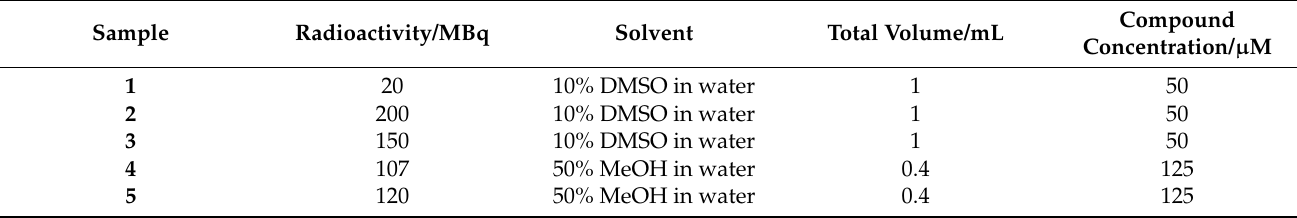
Table 2. Trials from cagedAZD5438 activation experiments using 18 F and 18 FDG as the radioactive source. As a solubilizer, either DMSO or MeOH was added. Each sample was analyzed by HPLC every 15 min for up to 24 h in two independent experiments. Following incubation with 18 F and 18 FDG showing no uncaging of cagedAZD5438, samples 1–5 were irradiated with UV light, yielding AZD5438 (positive controls).